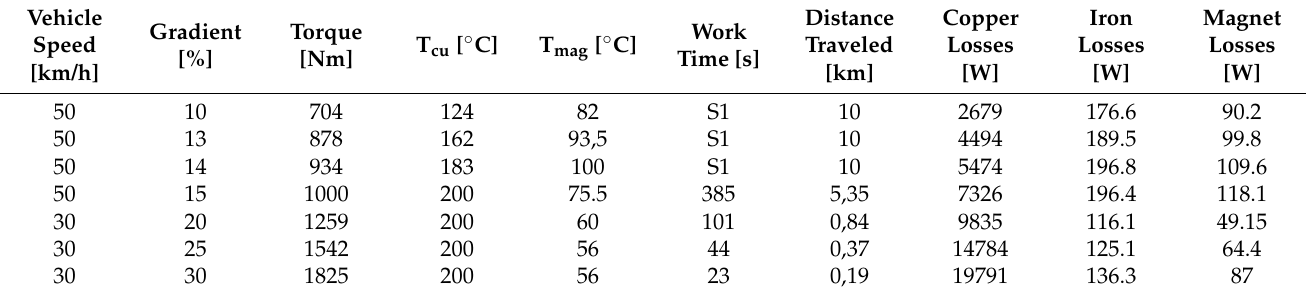
Table 5. Calculated motor operating parameters when driving the car on the road with different